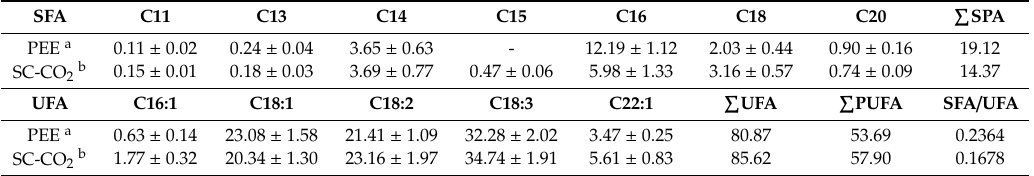
Table 5. Fatty acid composition and content of B. dasystachya seed oil by PEE and SC-CO 2 extraction (area%, n =